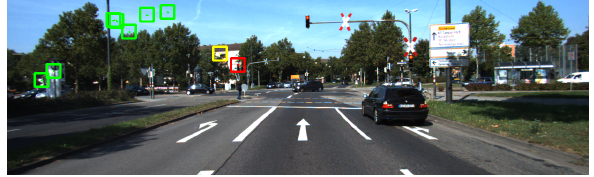
Figure 6: The traffic light lenses are detected using mono camera.